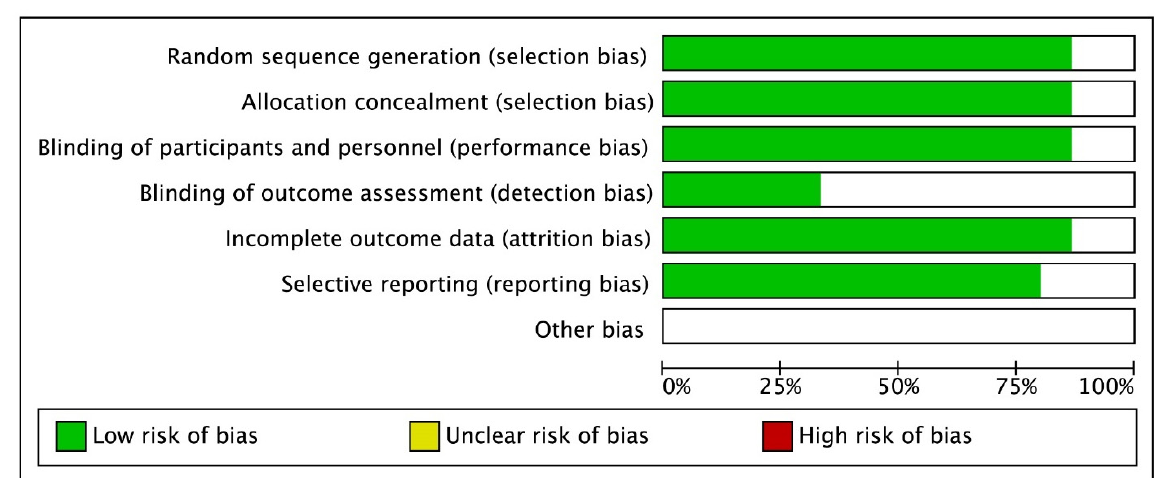
Figure 2. Quality evaluation results of RCTs. Figure 2. Quality Evaluation Results of